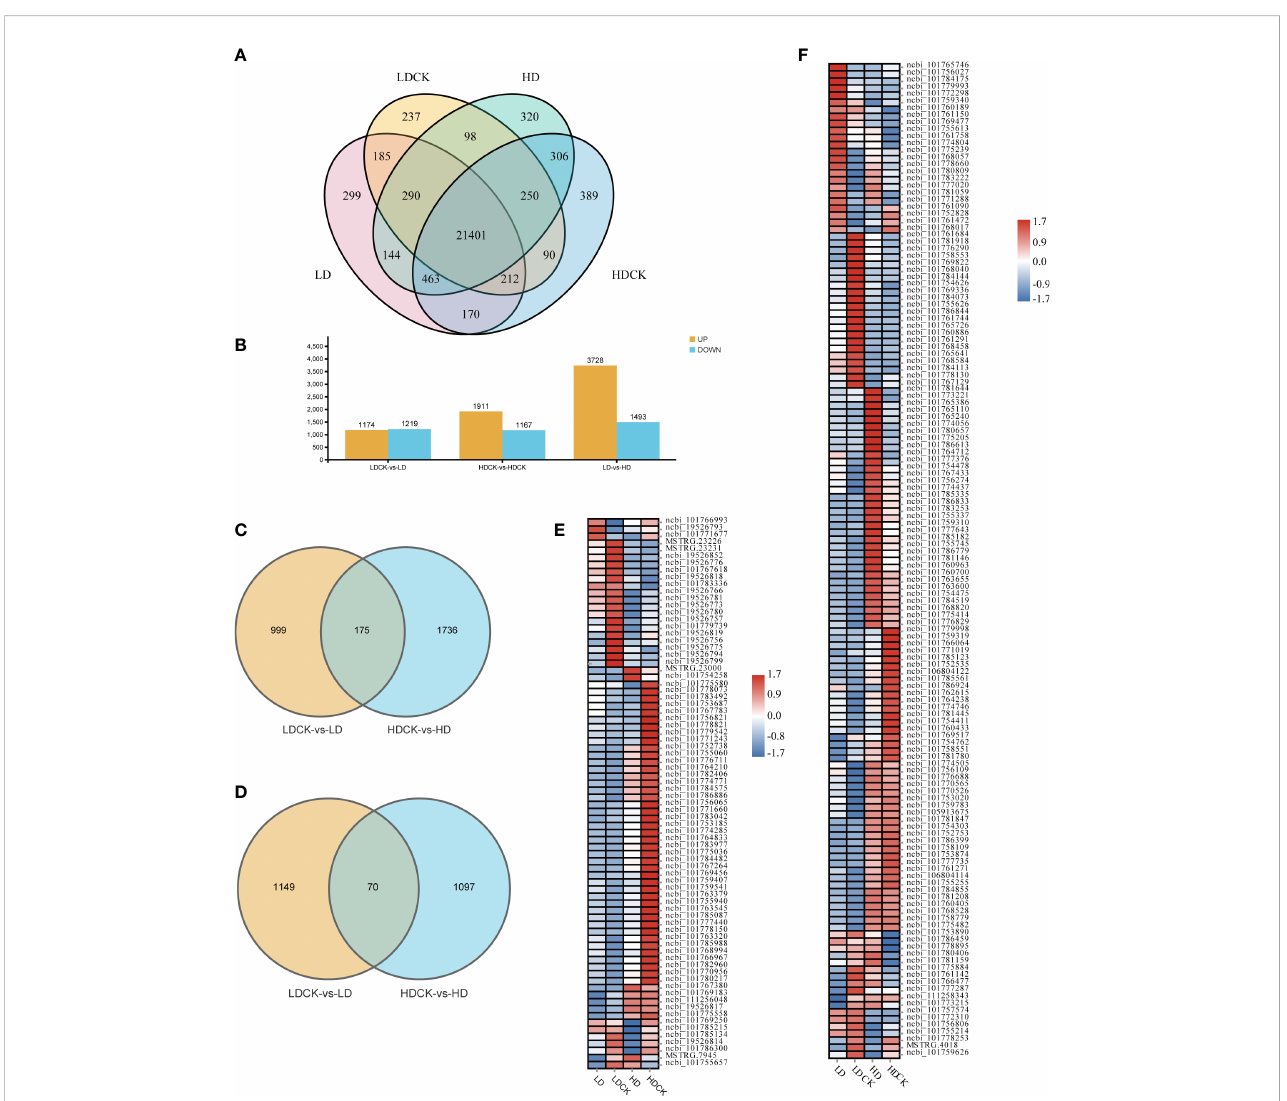
FIGURE 3 Number of expressed genes with and without simulated drought. The number of genes was selected based on the cut-off values of FDR ≤ 0.05 and |log 2 FC| ≥ 1. (A) Number of genes expressed in each treatment under drought stress. (B) Summary of the number of DEGs under drought stress; (C) Venn diagrams, representing DEGs including upregulated genes in LDCK and LD and HDCK and HD; (D) Venn diagrams, representing DEGs including downregulated genes in LDCK and LD and HDCK and HD; (E) Comparison of photosynthesis under drought stress; (F) Synthesis of sucrose and starch under genetic drought